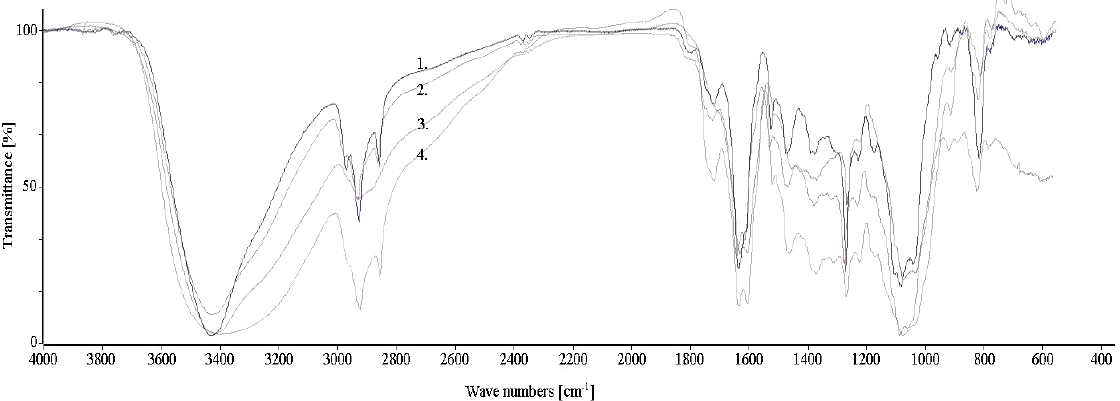
Figure 1. FT-IR spectra for F. alnus Mill extracts extracted with: 1. isopropanol, 2. ethanol, 3. distilled water, 4. methanol.